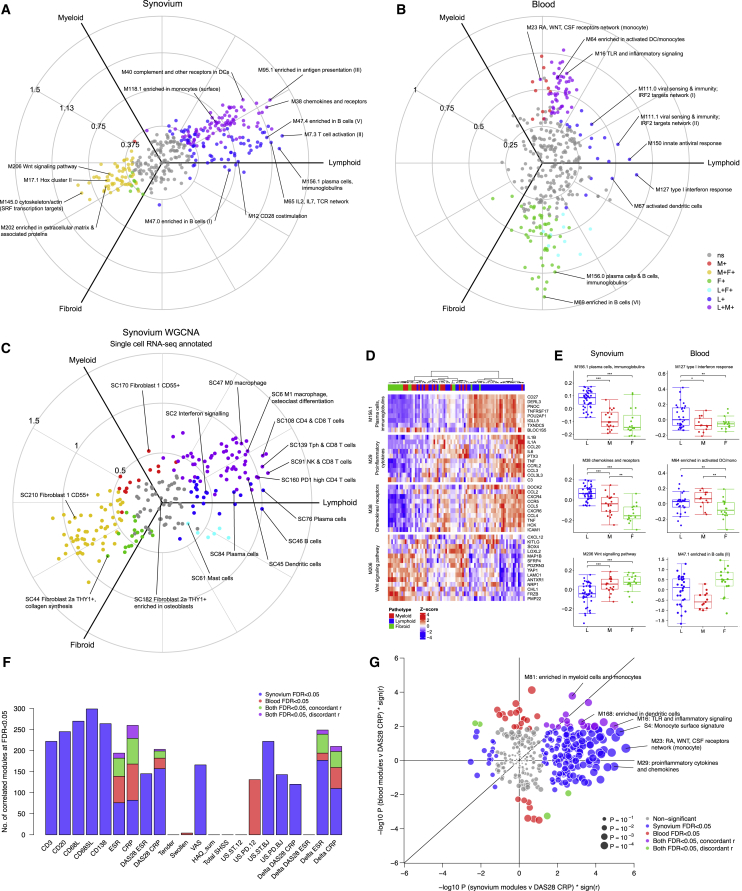
Modular Analysis of Synovial and Blood RNA Sequencing(A–C) Three axis polar plots of synovium (A) and blood (B) gene modules based on blood microarray modules (Li et al., 2014) and (C) synovium modules derived by weighted correlation network analysis (WGCNA), analyzed using QuSAGE. Modules are color-coded for statistical significance (FDR < 0.05) for upregulation in different pathotypes. WGCNA synovium modules were annotated against single-cell RNA-seq cell types (Stephenson et al., 2018).(D) Heatmap showing gene expression in selected gene modules in synovium and blood, grouped by pathotype.(E) Boxplots of summarized module scores in synovium and blood. Statistical analysis by QuSAGE with FDR correction: ∗FDR < 0.05, ∗∗FDR < 0.01, ∗∗∗FDR < 0.001.(F) Comparison of number of significant (FDR < 0.05) synovium and blood gene modules (Li et al., 2014), which correlate with clinical and radiographic markers of disease activity and response to 6 months treatment with DMARDs, in either synovium only (blue) or blood only (red) or are concordantly correlated in both compartments (purple). Statistical analysis by Spearman correlation.(G) Bubble plot of –log10 p values comparing correlation of gene modules in synovium and blood with disease activity measured by DAS28-CRP, showing significantly (FDR < 0.05) correlated modules found in synovium alone (blue), blood alone (red), or concordantly correlated with DAS28-CRP in both synovium and blood (purple).